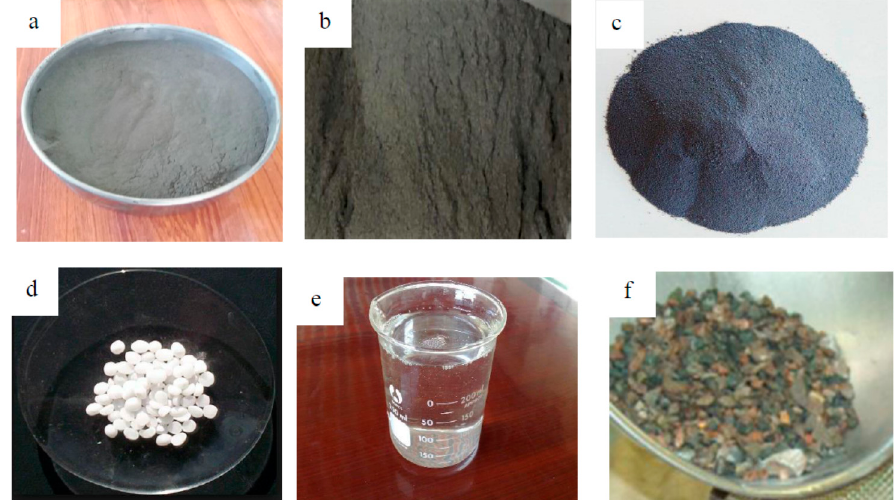
Figure 2. Constituents of geopolymer concrete (GPC): ( a ) Ordinary Portland Cement (OPC), ( b ) fly ash (FA), ( c ) silica fume (SF), ( d ) NaOH pellets, ( e ) Na 2 SiO 3 , ( f ) GPC aggregate.